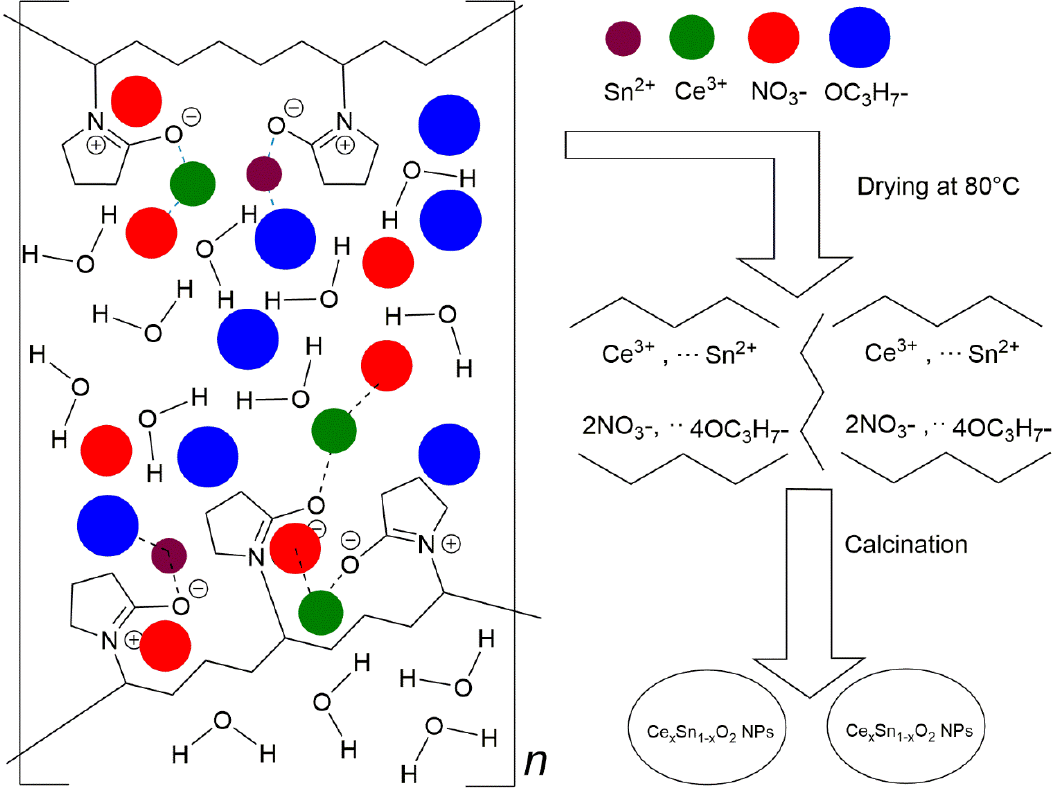
Figure 2. Schematic illustration of the proposed mechanism of interaction between metal ions and PVP. P VP’s main role in the employed method is to control the growth of the particles by forming passivation layers around the metal. In addition, the functions of PVP during the preparation of Ce x Sn 1 − x O 2 nanoparticles are to regulate the expansion nucleation of